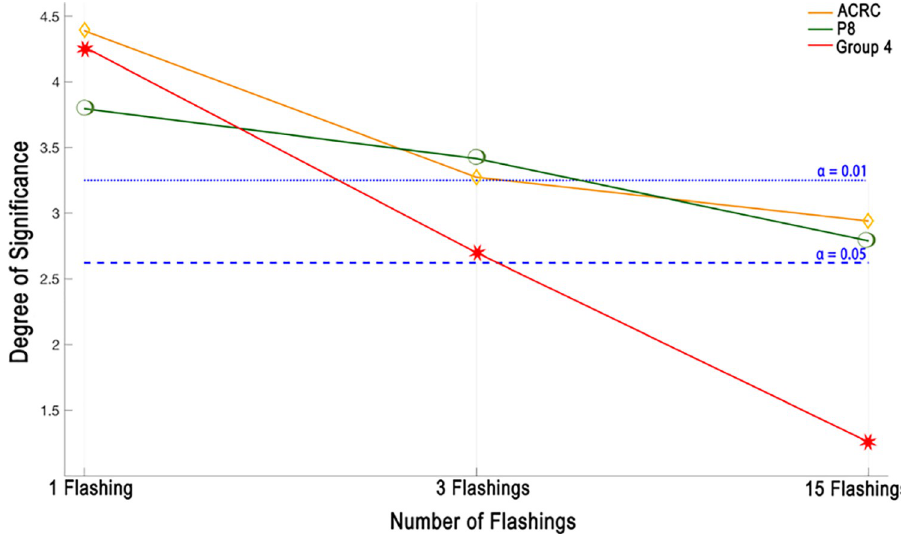
Fig 15. Degree of significant results in terms of group EEG electrodes according to different number of flashing classification accuracy results.